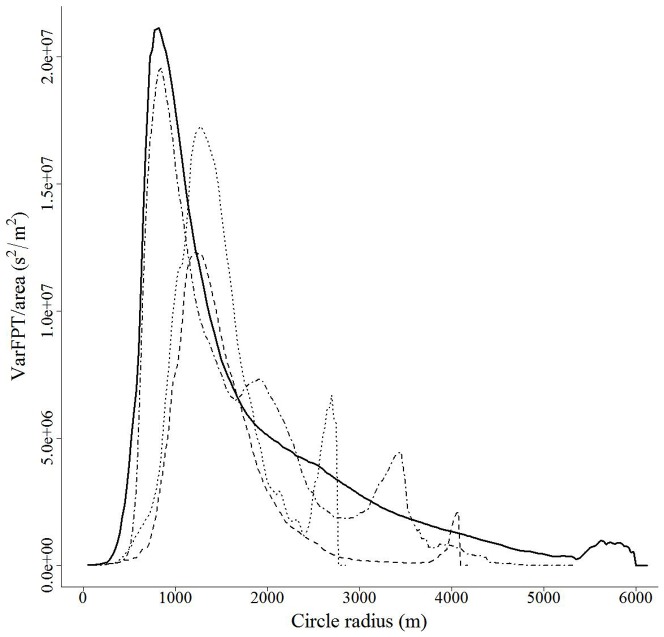
Plots of area adjusted variance in first-passage time (varFPT/area, s2/m2) as a function of the scale used to determine passage time along the observed movement path (radius of circle, m) for 4 white-tailed deer in central New York.Peaks in varFPT/area indicate the landscape scale(s) to which individuals are responding by altering time spent along their movement path.